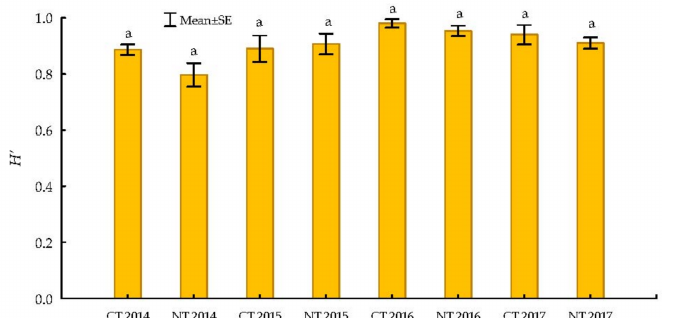
Figure 8. Interactive dependencies of tillage system and years of research in shaping of Shannon- Wiener’s diversity index (H’) of weed community in winter oilseed rape crop. CT—Conventional tillage; NT—No-tillage. The same letter means not significantly different values ( p ≤